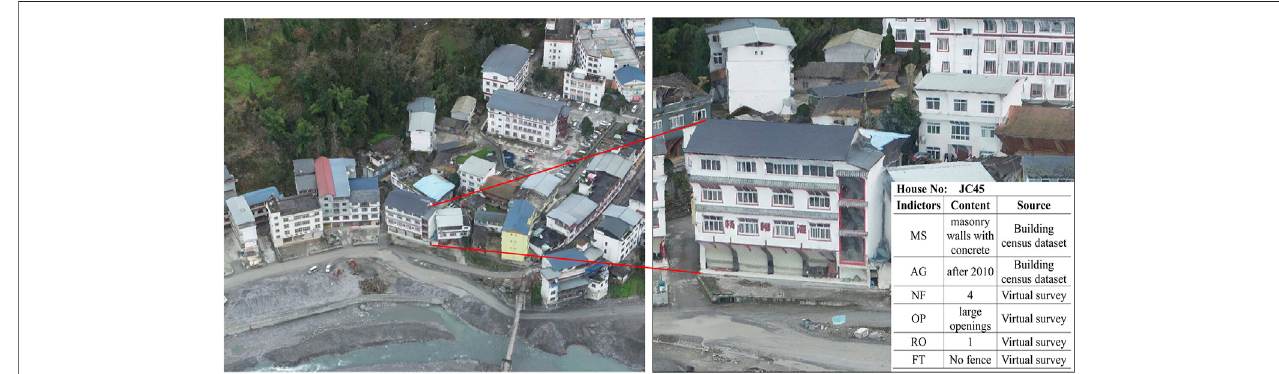
FIGURE 3 | An example of building information collection via virtual survey.